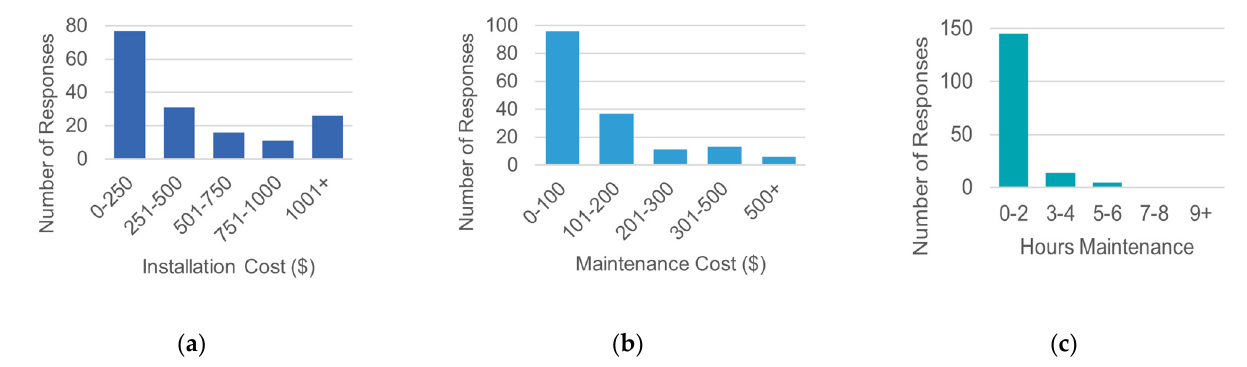
Figure 10. ( a ) The initial cost of installing verge gardens reported by respondents; ( b ) the cost of maintaining verge gardens; ( c ) number of hours spent maintaining the verge garden. maintaining verge gardens; ( c ) number of hours spent maintaining the verge